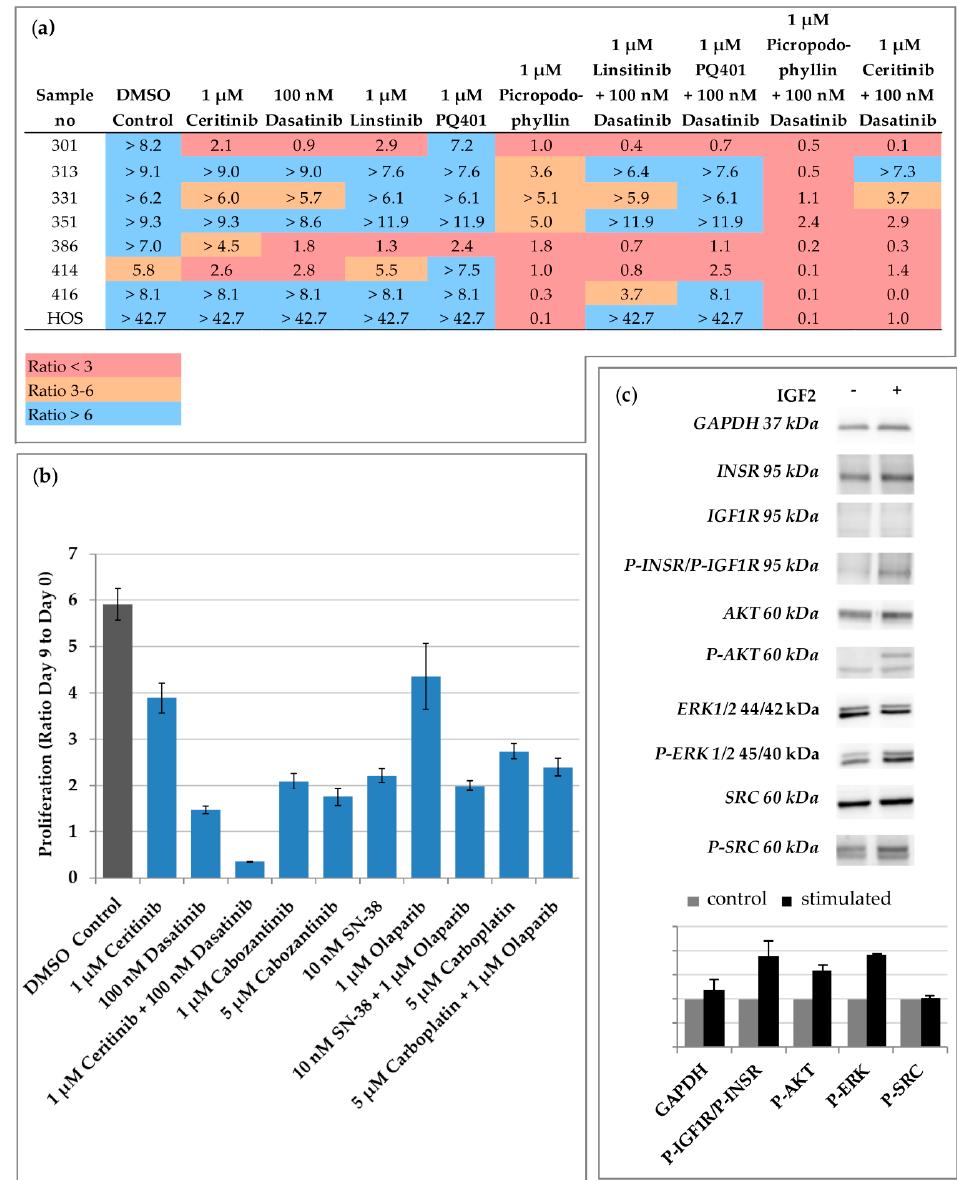
Figure 1. Drug screening identifies ceritinib and dasatinib as potent inhibitors of OS proliferation in vitro. ( a ) Primary tumor cells of six patients (corresponding to seven samples) and the HOS cells were incubated with the indicated inhibitors. After nine days, the cell proliferation was measured. The ratio between the absorbance at day nine and the absorbance at day zero is indicated. At least two independent experiments were used to calculate the ratio and each experiment was done in triplicates. Low proliferation is outlined in red, middle in orange, and strong in blue. ( b ) The primary tumor cells of sample 386 were incubated with the indicated inhibitors. After nine days, the cell proliferation was measured and the ratio between the absorbance at day nine and the absorbance at day zero was calculated. The proliferation experiments were carried out in biological duplicates. Data are represented as the mean ± Standard deviation (SD). ( c ) 386 cells were stimulated after starvation with IGF2. The expression of IGF1R, INSR, AKT serine/threonine kinase 1 (AKT), extracellular-signal regulated kinases (ERK), kinase Src (Src) and their phosphorylated (P) form was analyzed by Western blot with specific antibodies. Glyceraldehyde-3-phosphate dehydrogenase (GAPDH) was used as loading control. A representative experiment of three independent experiments is shown. Densitometric analysis of two independent experiments is shown. The control (unstimulated) condition was normalized to one.